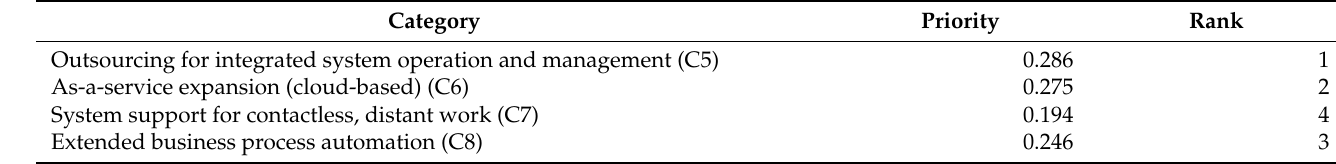
Table 11. Consolidated priorities for D2 sub-criteria.